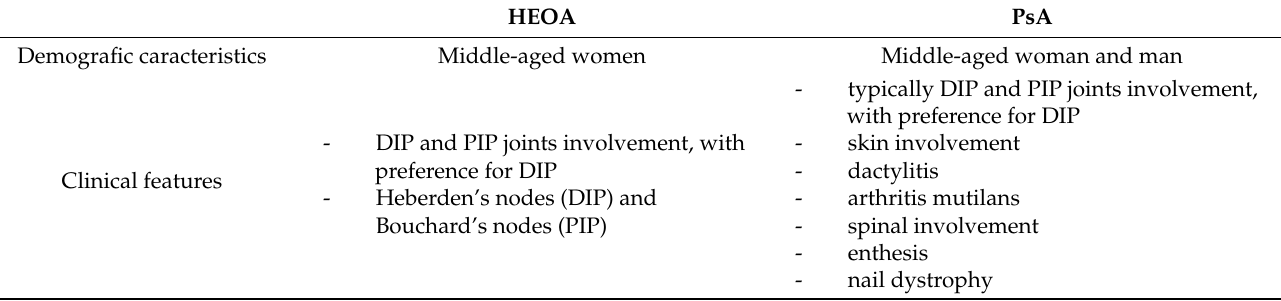
Table 1. Demographic, clinical and imaging features of patients with Erosive Hand Osteoarthritis (HEOA) and Psoriatic Arthritis (PsA).